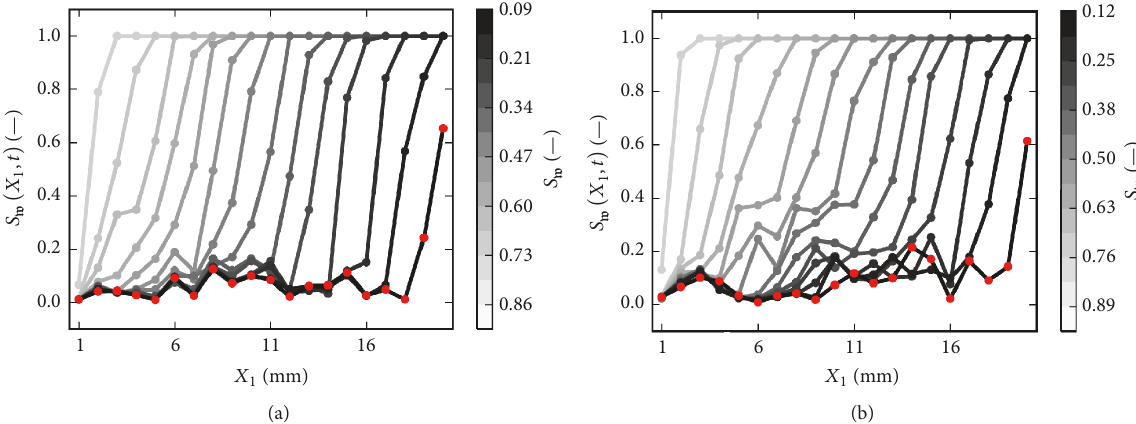
Figure 5: Evolving saturation profiles in flow direction for stable displacement in microstructures A (a) and C (b) at log 10 ( Ca ,𝑀) = (−2,1) . Among the tested microstructures, microstructure A exhibits the narrowest grain diameter distribution and microstructure C exhibits the widest one. Width of vertical slices for computing saturation profiles was chosen Δ𝑋 1 = 𝐿 𝑊 /20 . Red markers indicate residual saturation profile 𝑆 𝐵 w (𝑋 1 ) at breakthrough.